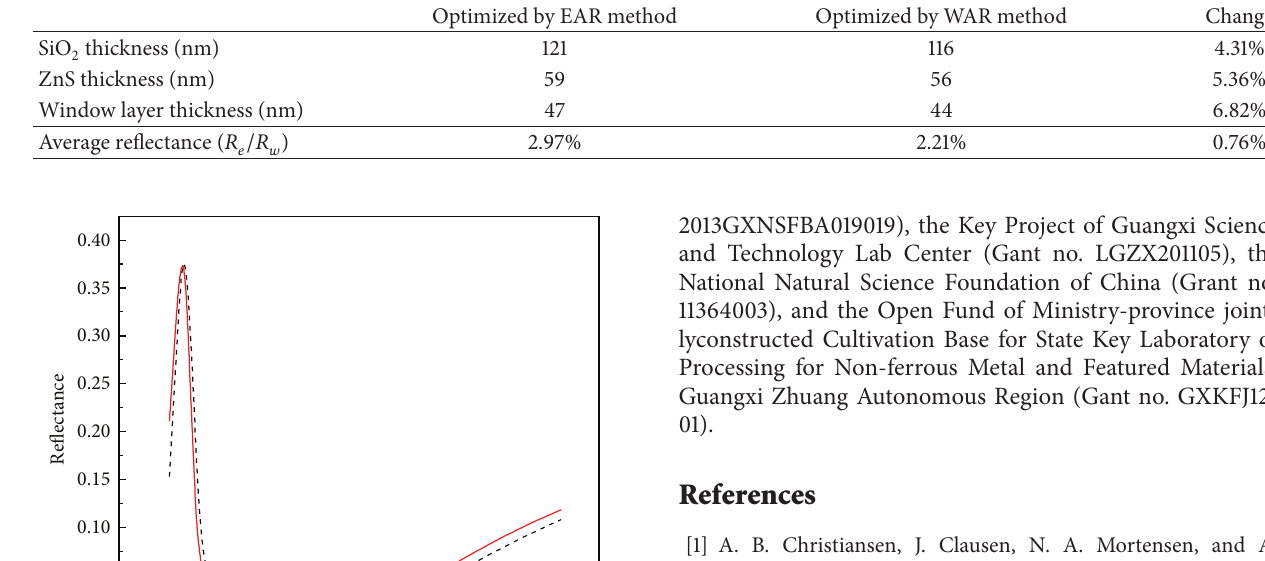
Table 2: Comparison of parameters of SiO